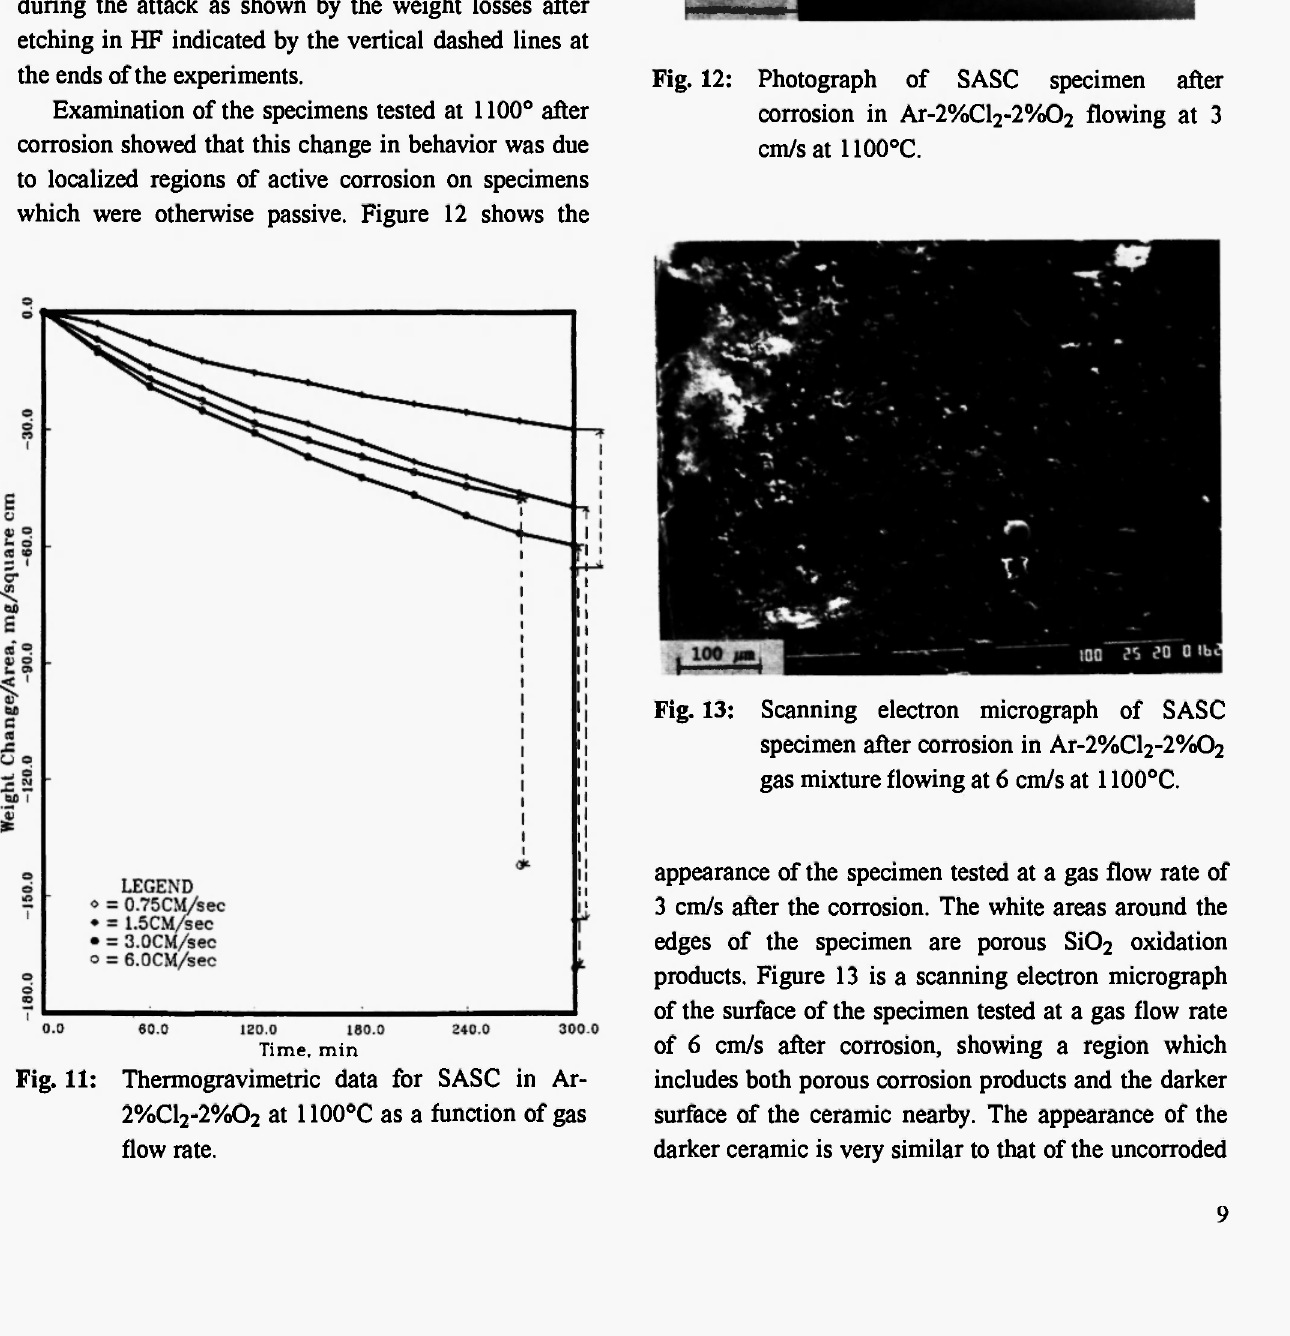
-2%0 flowing at 3 2 2